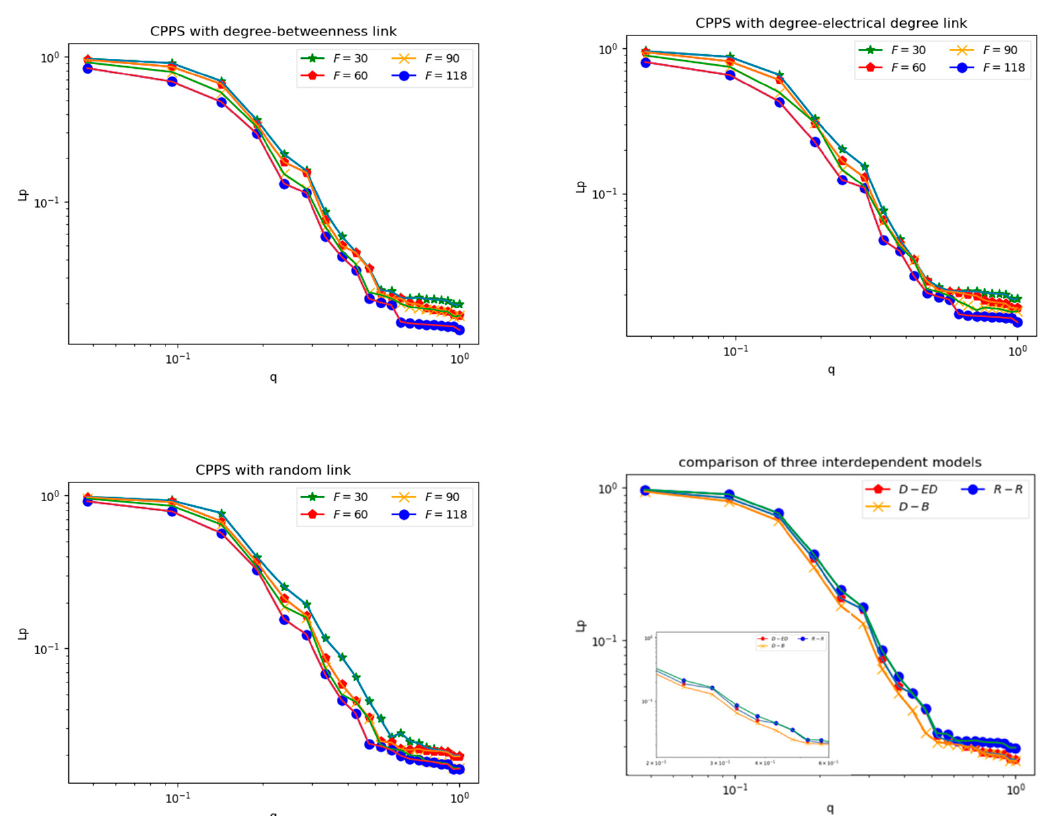
Figure 9. The vulnerability of CPPS under malicious attack.